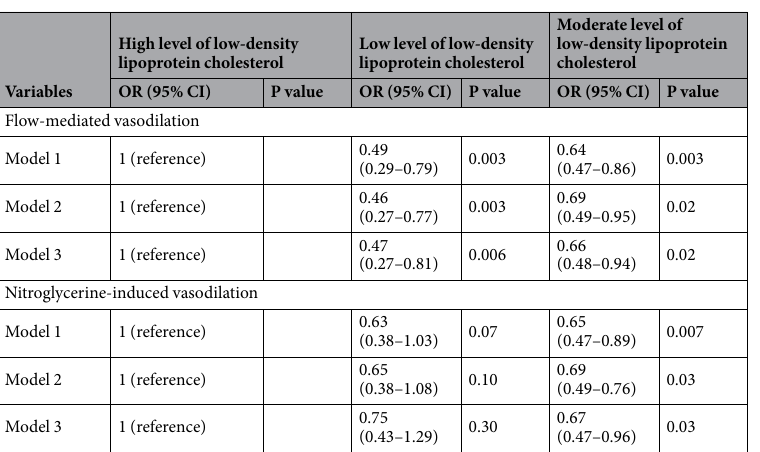
Moderate level of low-density lipoprotein cholesterol